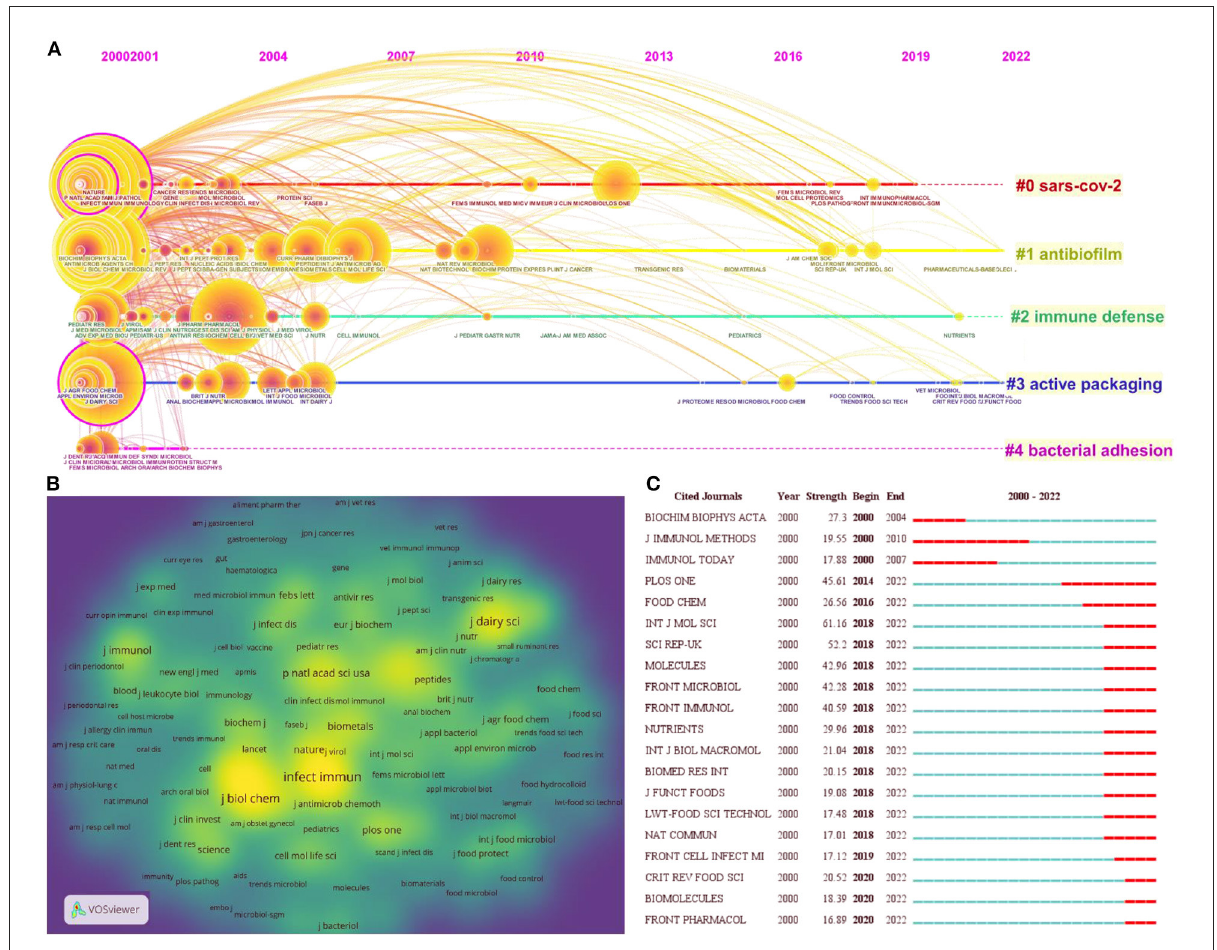
FIGURE5 (A) Timeline view of journals cluster analysis in LF antibacterial research. (B) Density visualization for journals of cluster in cocited journals network map. (C) Top 20 cocited journals with strong occurrence bursts in LF antibacterial